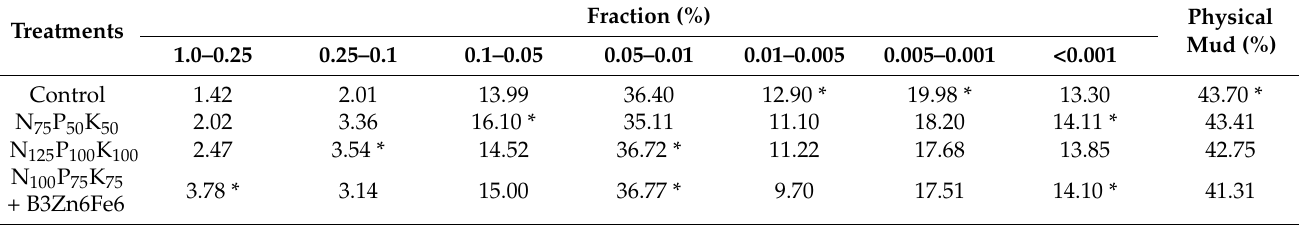
Table 4. The effect of mineral fertilisers on the mechanical composition of irrigated soil in the Kibray district.